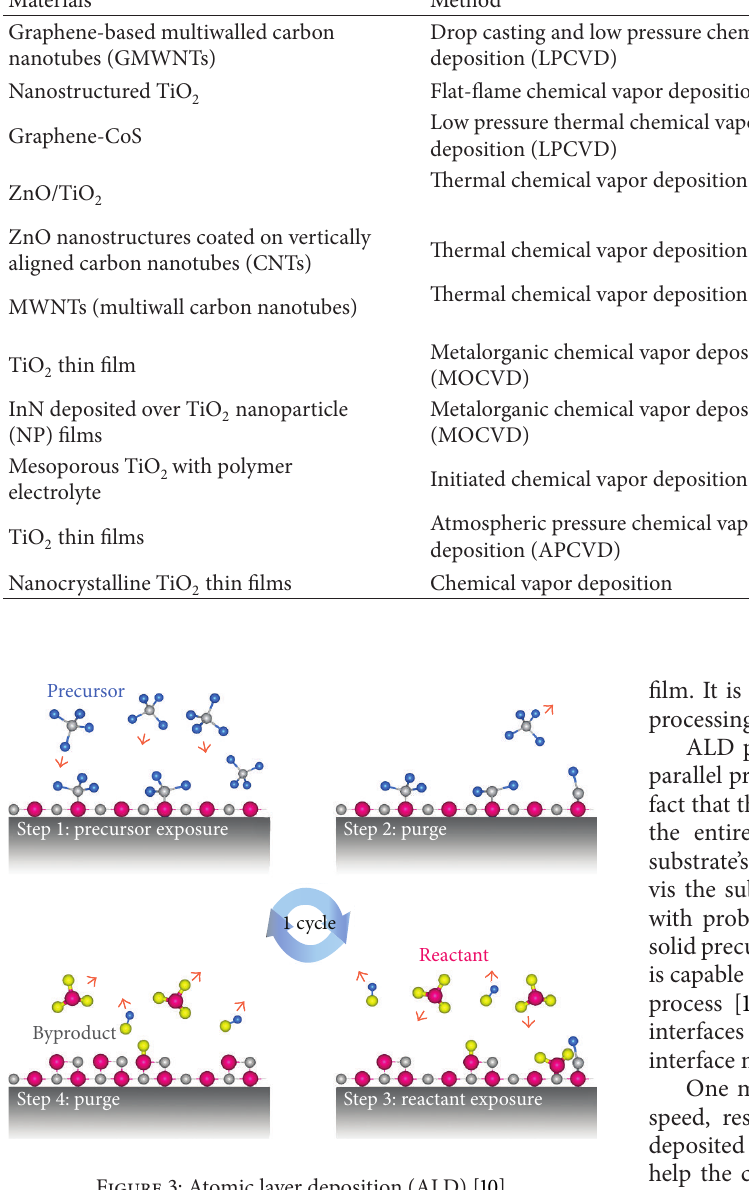
Figure 3: Atomic layer deposition (ALD)